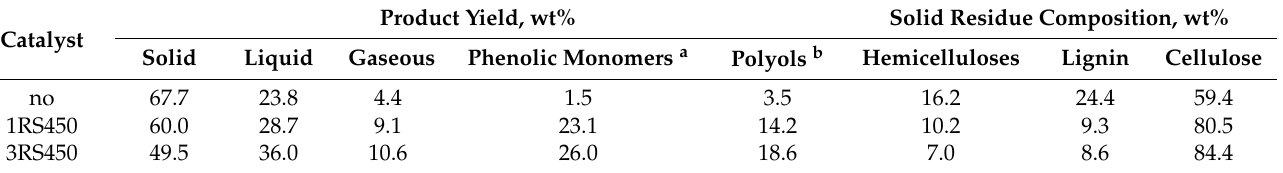
Table 3. The effect of ruthenium content in the catalyst on the yield and composition of products of spruce wood RCF at 225 ◦ C for 3